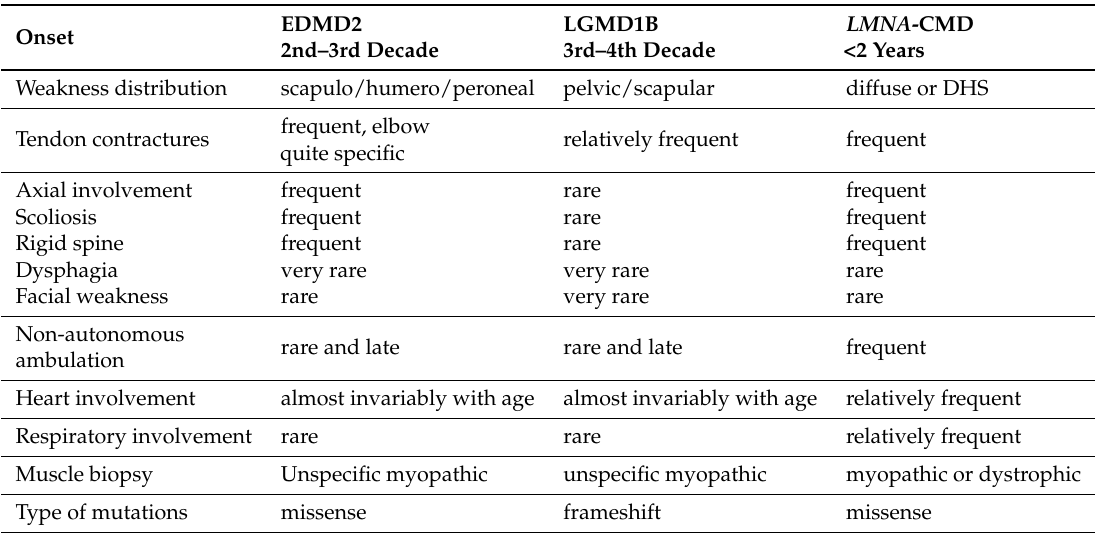
Table 1. Clinical and genetic characteristics of patients with